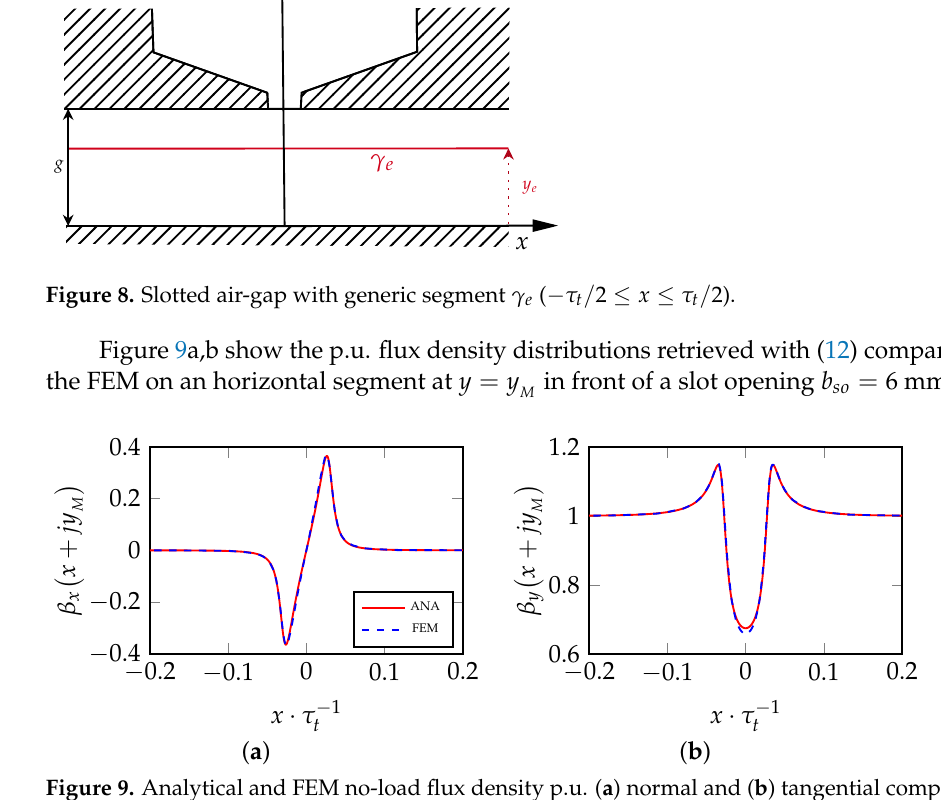
( 1 / 5 τ t 1 / 5 τ t N x = 1000, N h = x M − ≤ ≤